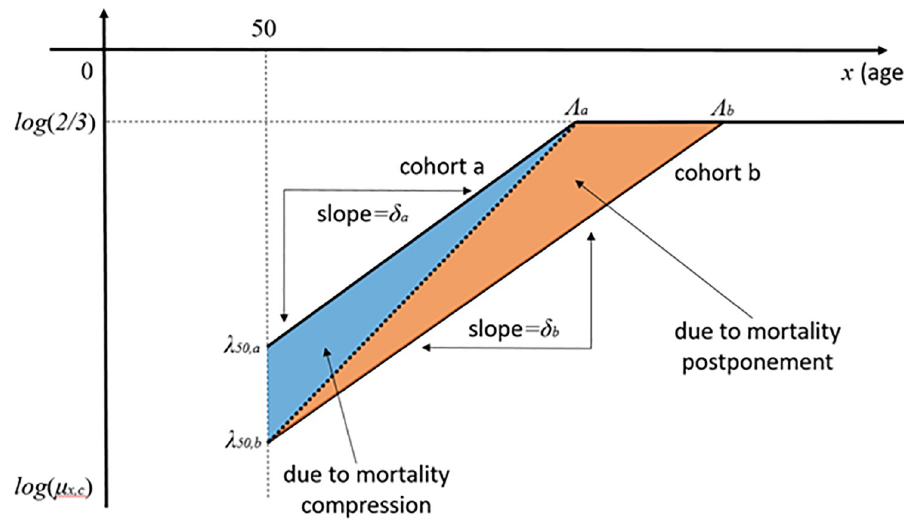
Fig 1. Dividing changes in mortality rates between compression and